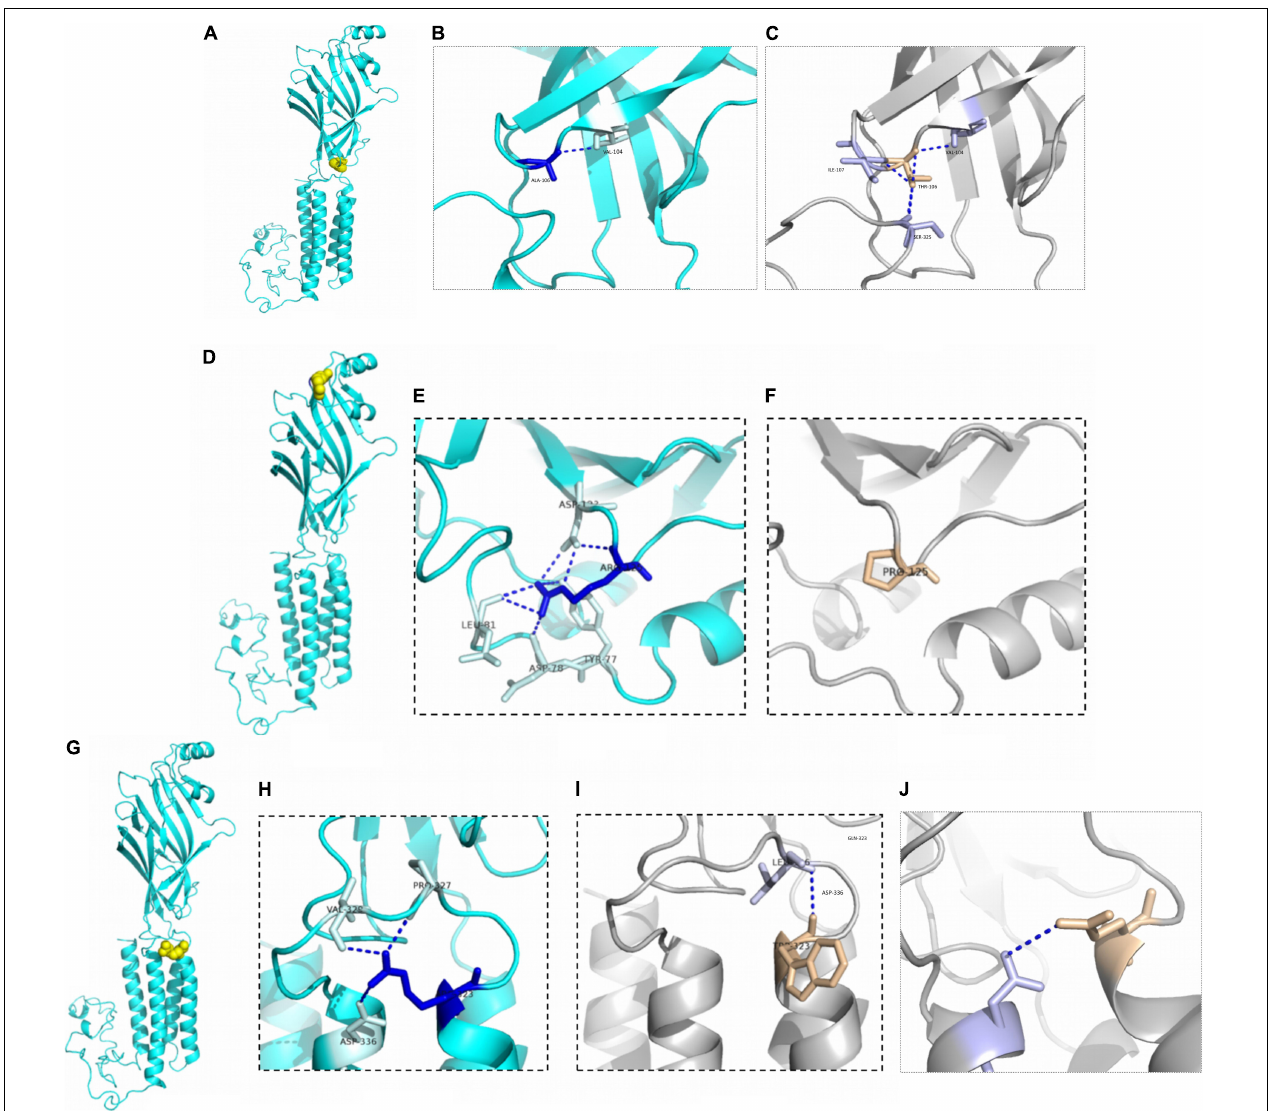
FIGURE 3 | Structural modeling of GABRG2 variants (A106T, R125P, R323W, and R323Q). (A) The position of the 106th amino acid in the subunit (yellow). (B) Wild-type 106A forms ionic bonds with surrounding amino acid residues. (C) The number of ionic bonds between variant 125T amino acid residues and surrounding amino acid residues is increased. (D) The position of the 125th amino acid in the subunit (yellow). (E) Wild-type 125R forms ionic bonds with surrounding amino acid residues. (F) The number of ionic bonds between variant 125P amino acid residues and surrounding amino acid residues is reduced. (G) The position of the 323rd amino acid in the subunit (yellow). (H) Wild-type 323R forms ionic bonds with surrounding amino acid residues. (I) Change in forces between variant 323W amino acid residues and adjacent α helix. (J) Change in forces between variant 323Q amino acid